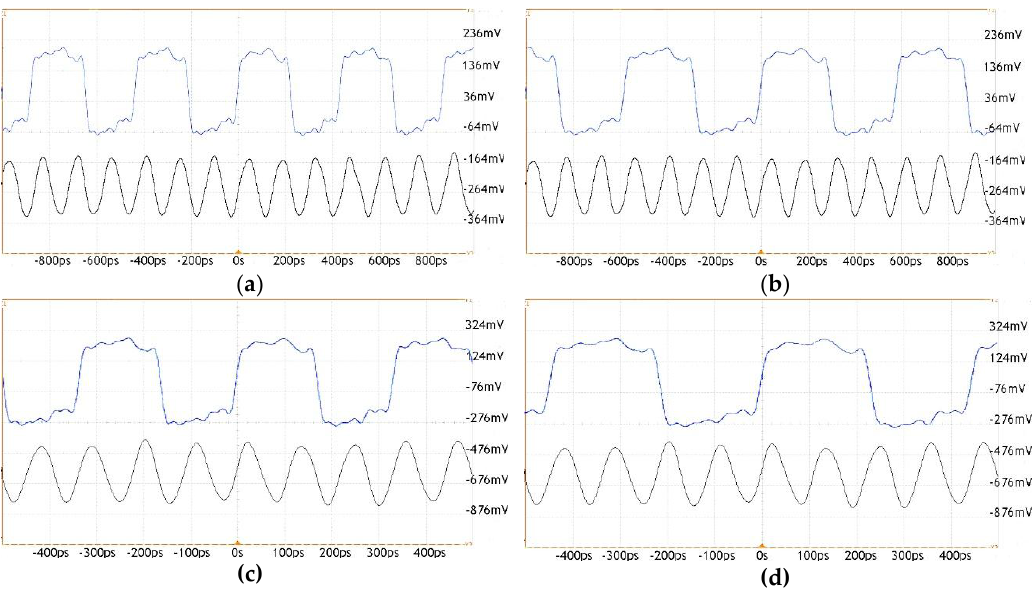
Figure 8. The measured waveforms of ( a ) divide-by-3 at 6.9 GHz under 1.1 V; ( b ) divide-by-4 at 6.9 GHz under 1.1 V; ( c ) divide-by-3 at 9 GHz under 1.35V; ( d ) divide-by-4 at 9 GHz under 1.35 V.